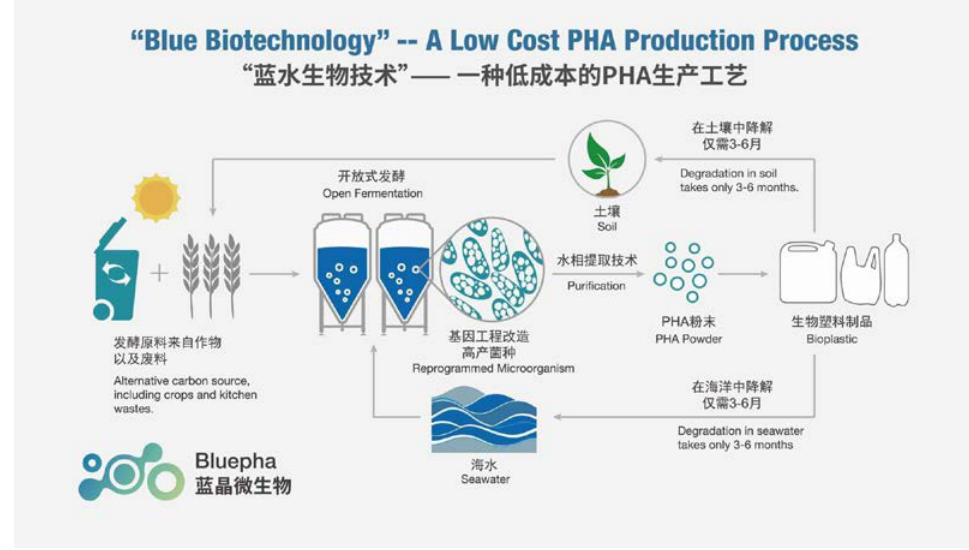
Figure 2. Illustration of the “Bluepha” process for industrial PHA production based on the principles of Next Generation Industrial Biotechnology (NGIB) [115]. The English and Chinese text are the same.